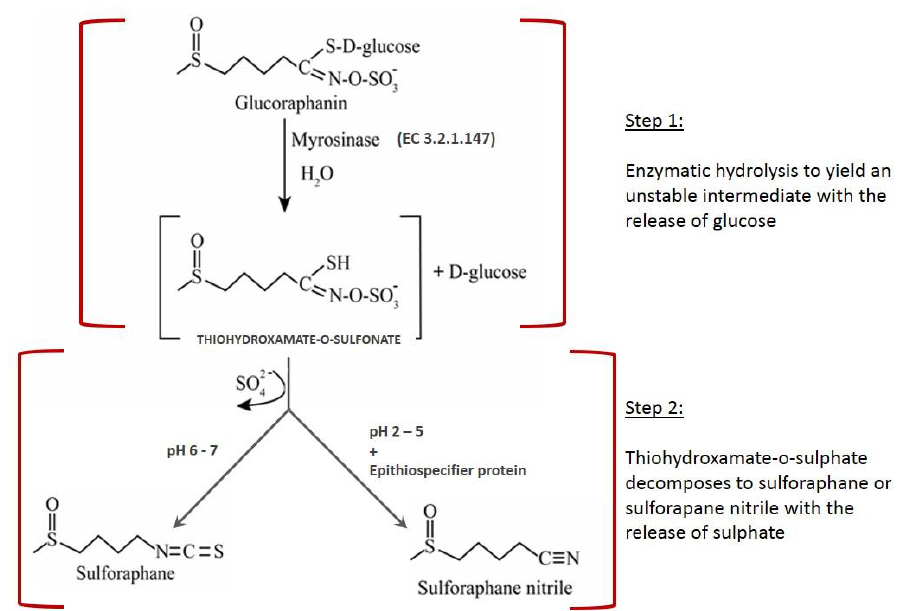
Figure 1. Schematic representation of glucoraphanin hydrolysis by myrosinase.